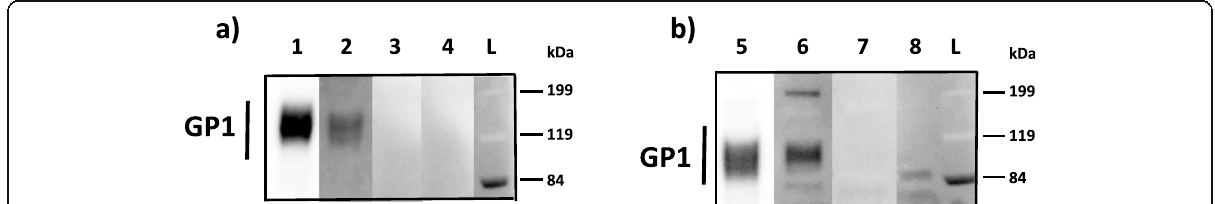
Fig. 4 Distribution of EBOV and BOMV (*) seropositive samples by month and year by indirect